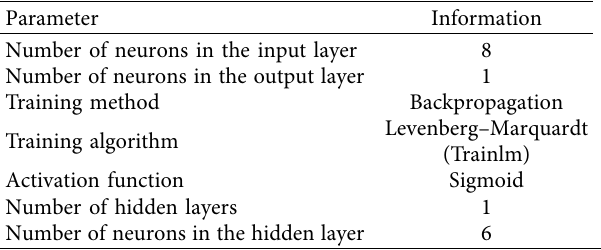
Figure 4: Activation function and model performance. (a) Sigmoid function. (b) Average results from 20 ANN models. Table 4: Detailed information about the selected ANN model.